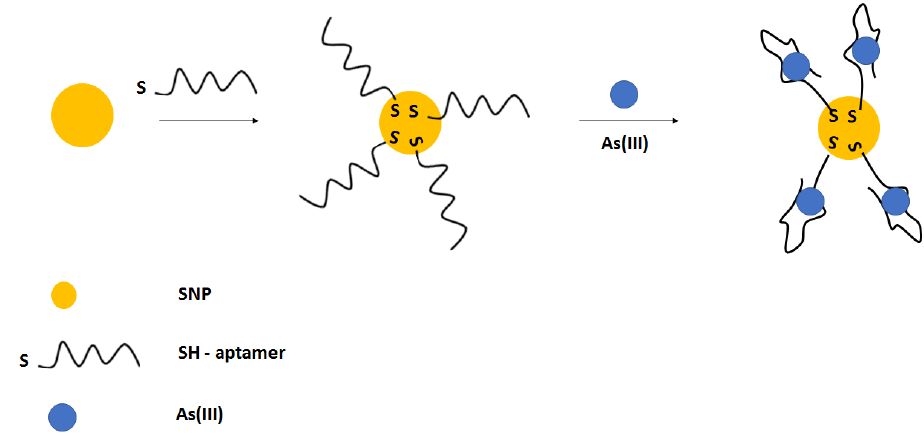
Figure 28. The sensing principle scheme of the colorimetric assay for arsenic ions detection.